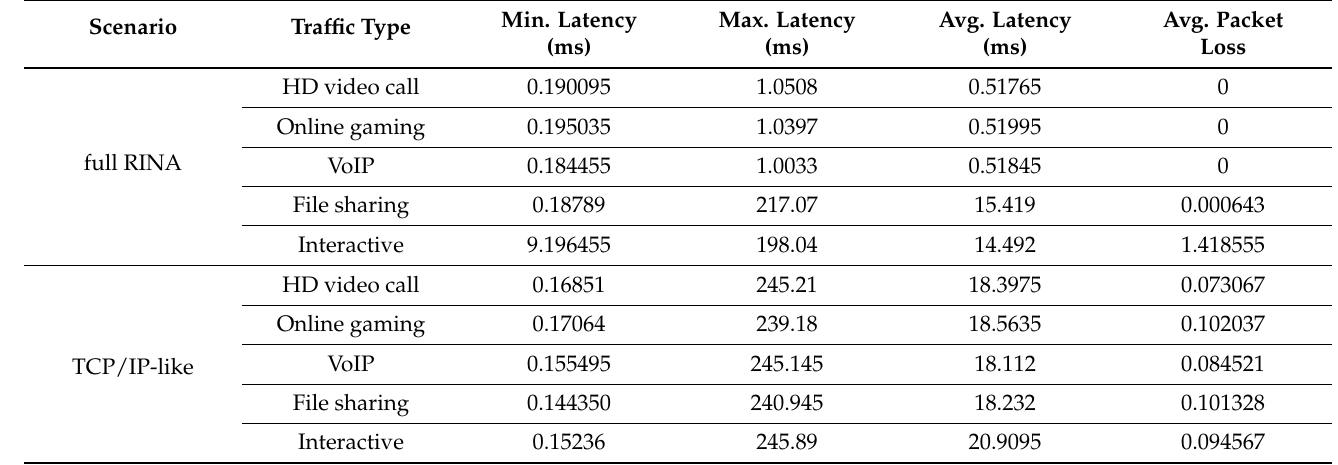
Table 5. Latency and packet loss at 90% offered